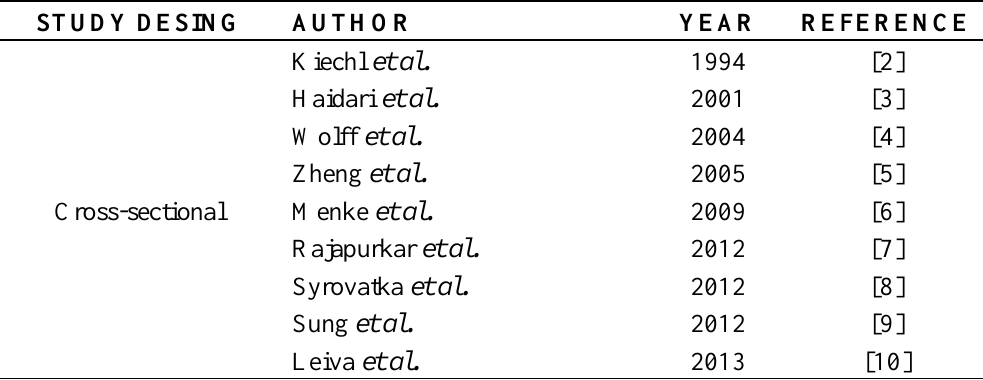
Table 1. Studies which support the iron